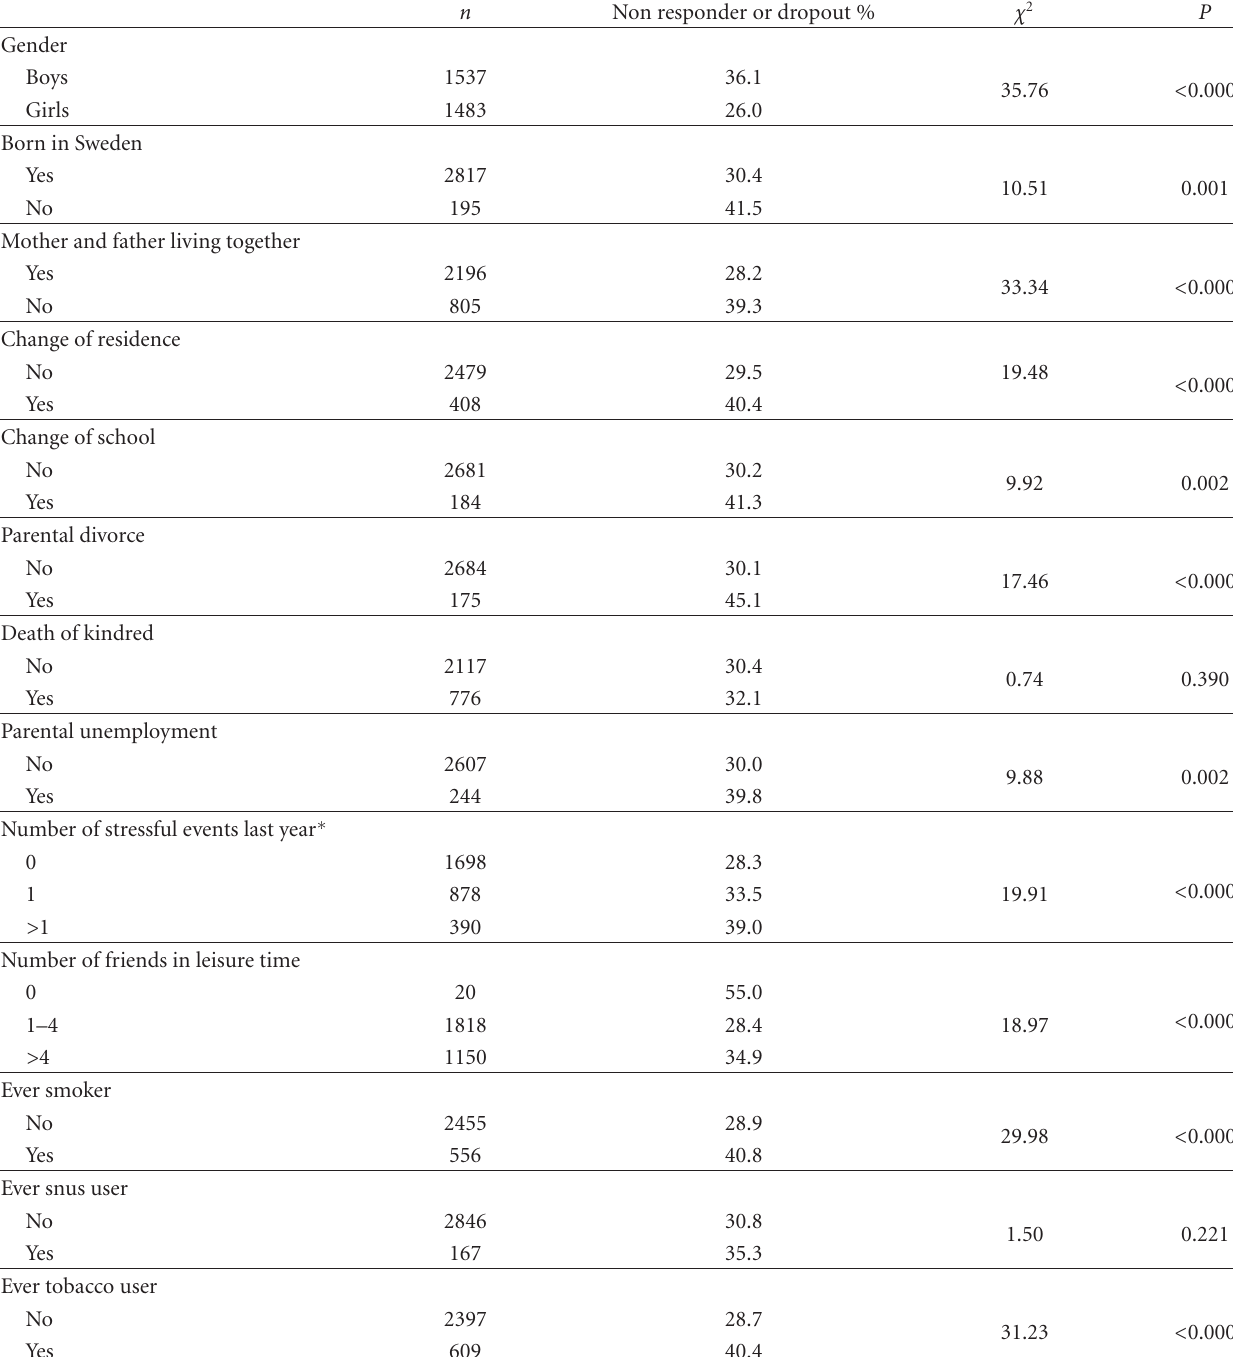
Table 2: Behavioural and psychosocial characteristics at baseline as predictors of non-participation in any followup